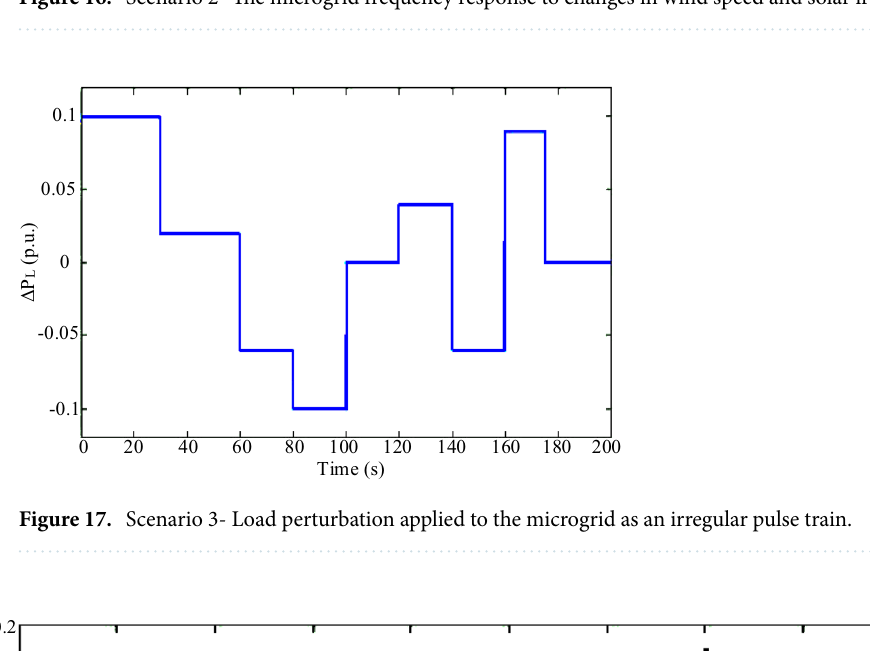
Figure 16. Scenario 2- The microgrid frequency response to changes in wind speed and solar irradiation.